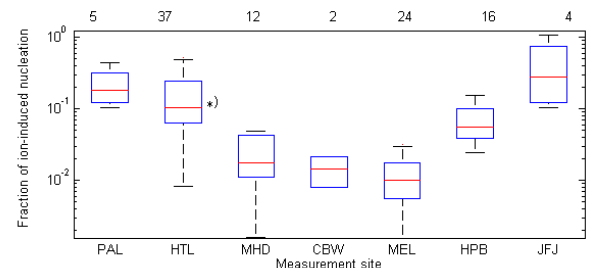
Fig. 8. Fraction of ion-induced nucleation according to formation rate calculations. These analyses include the observed NPF events at different field sites with the NAIS instruments during the EUCAARI project. The red lines show the medians, the boxes indicate the 25- and 75-percentiles, and the error bars the 5- and 95- percentiles. The numbers above the subplots refer to the number of NPF event days included in the analysis. * Manninen et al. (2009a).